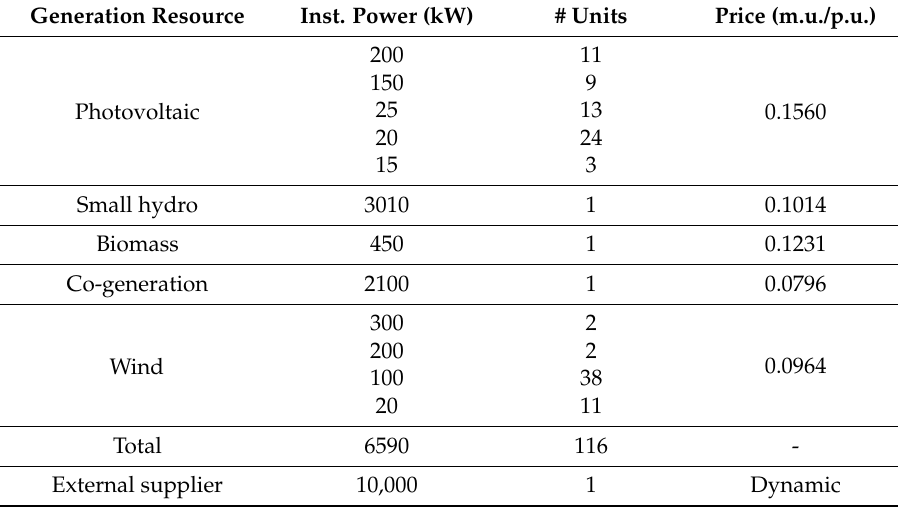
Table 1. Generation resources features.